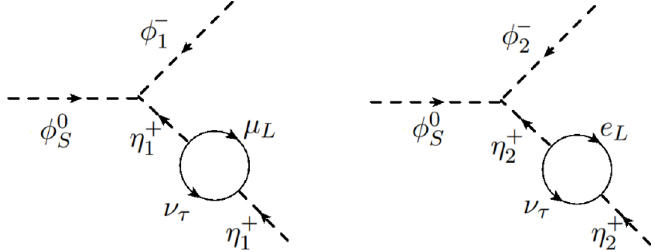
Figure 7 . Feynman diagrams generating shift in the cubic scalar couplings in the SU(2) H